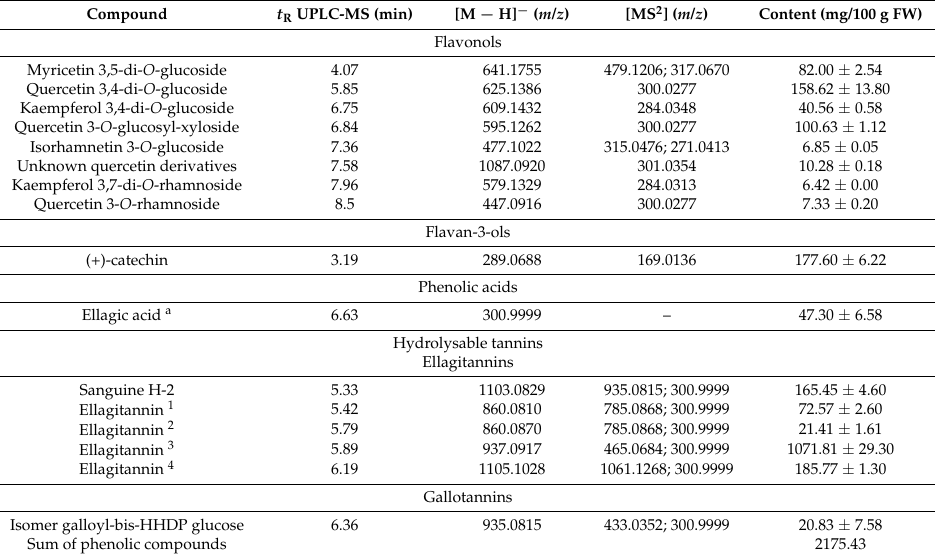
Table 1. The results of the identification and the quantitation of polyphenolic compounds in Rosa rugosa petals by